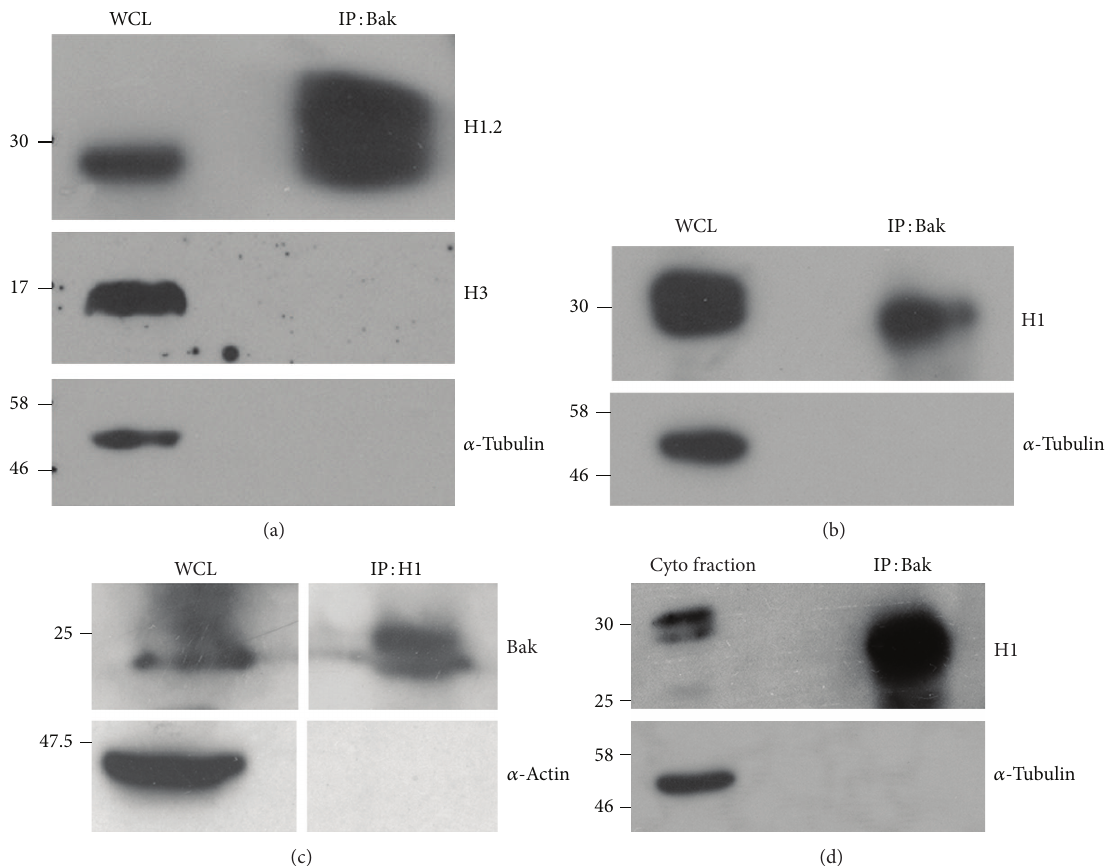
Figure 3: H1.2 immunoprecipitates with the mitochondrial outer-membrane resident Bak in T-effectors. (a)-(b) 10 × 10 6 T-effectors were cultured without cytokine and 6 hours later immunoprecipitated (IP) with an antibody to Bak. Immunoblots of whole cell lysates (WCL) or the IP were probed with an antibody to H1.2 (a) or a pan H1 antibody (b) and 𝛼 -Tubulin. (c) Reverse IP with an antibody to H1 in T-effectors cultured as described in (a)-(b) and the immunoblot probed for Bak. Actin is the specificity control. (d) 10 × 10 6 T-effectors were cultured without cytokine for 6 hours and the cytoplasmic fraction obtained by subcellular fractionation as described in Materials and Methods was used as input for an IP with an antibody to Bak. A representative immunoblot for H1 in the complex IP is shown. 𝛼 -Tubulin is the specificity